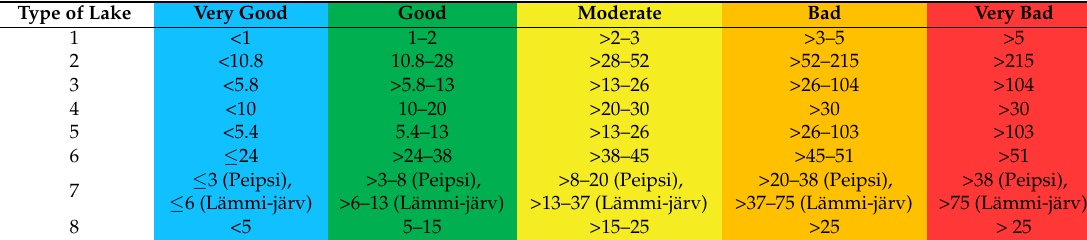
Table 2. Thresholds for chlorophyll a (chl a ) (mg/m 3 ) estimating the ecological status of water for different lake types. Each ecological status class is represented by defined colors [1]. Thresholds are defined according to the Estonian regulation of Water Act